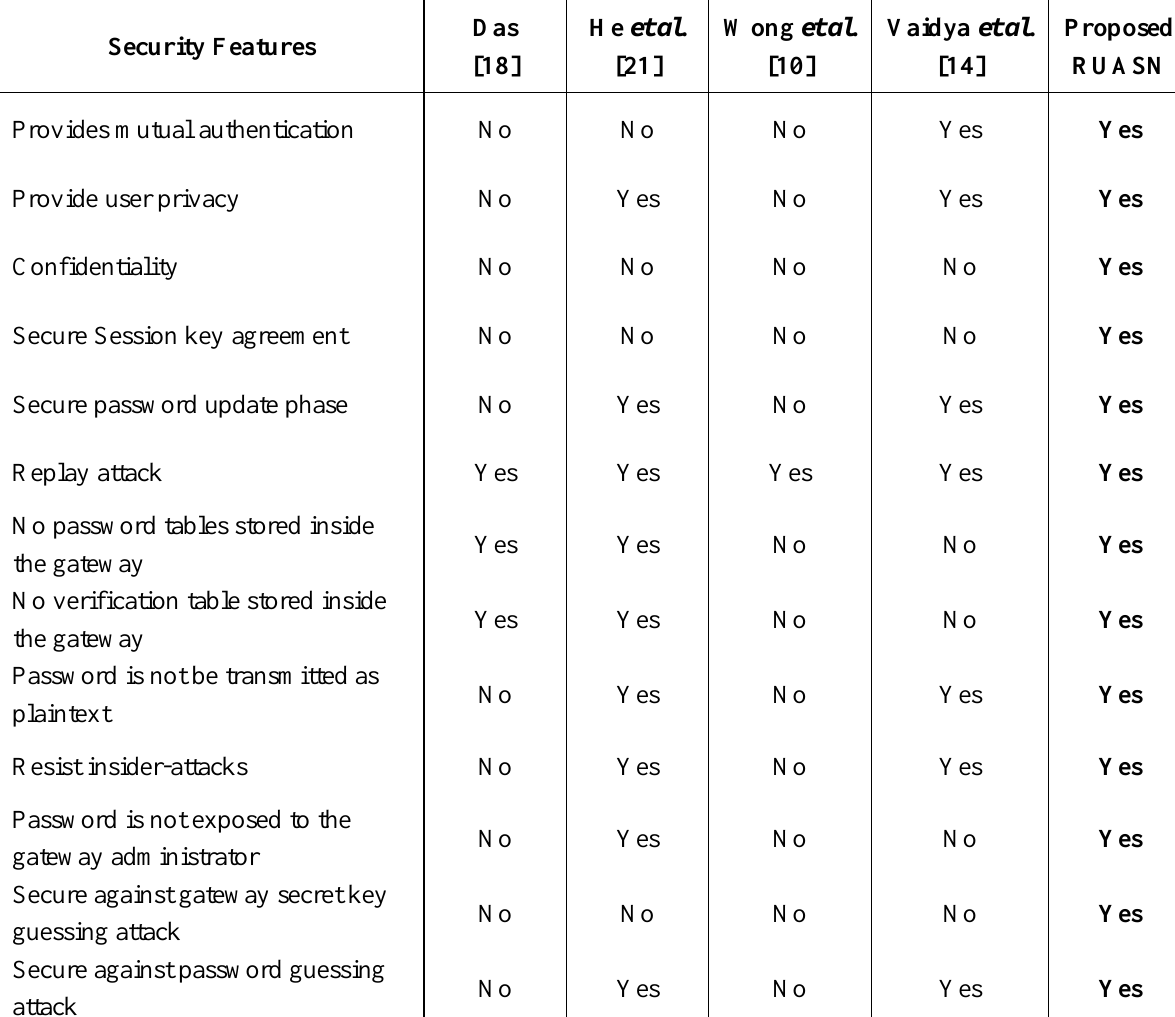
Table 5. Functionality comparison of RUASN with existing